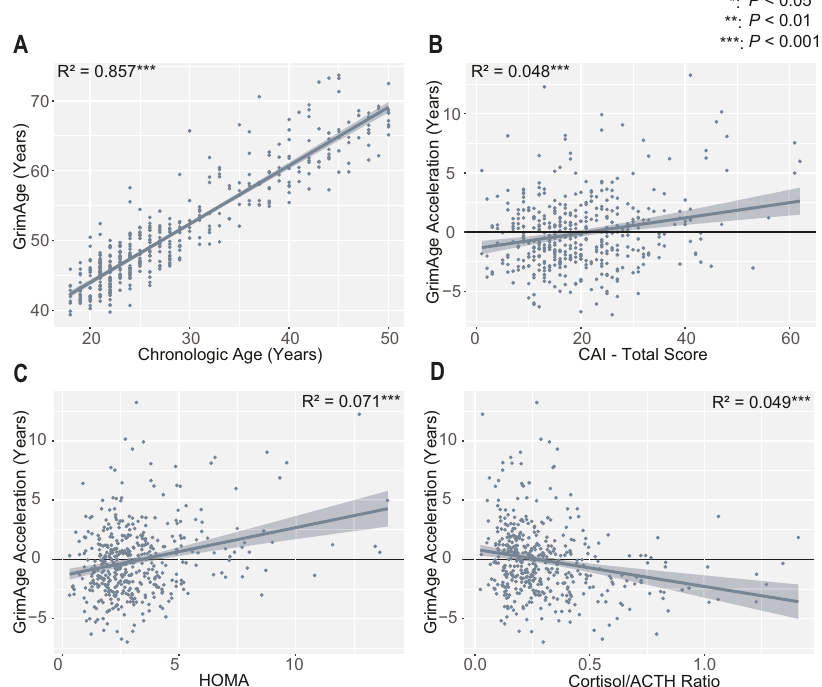
Fig. 2 GrimAge and GrimAge acceleration correlate with cumulative stress and physiologic stress pathways. A Chronologic age signi fi cantly predicts GrimAge ( P < 2e − 16). B Cumulative stress total as measured by the CAI (CAI-Total) signi fi cantly predicts GAA before ( P = 2.00e − 6) and after accounting for covariates. C Higher insulin resistance (as measured by HOMA) shows a signi fi cant positive correlation with GAA before ( P = 1.11e − 8) and after accounting for covariates. D The Cortisol/ACTH ratio is negatively correlated with GAA before accounting for covariates ( P = 2.39e − 6), but not afterward. P and R 2 values in the fi gure represent simple univariate models (Y ~ X). In the main text, models are adjusted for covariates as